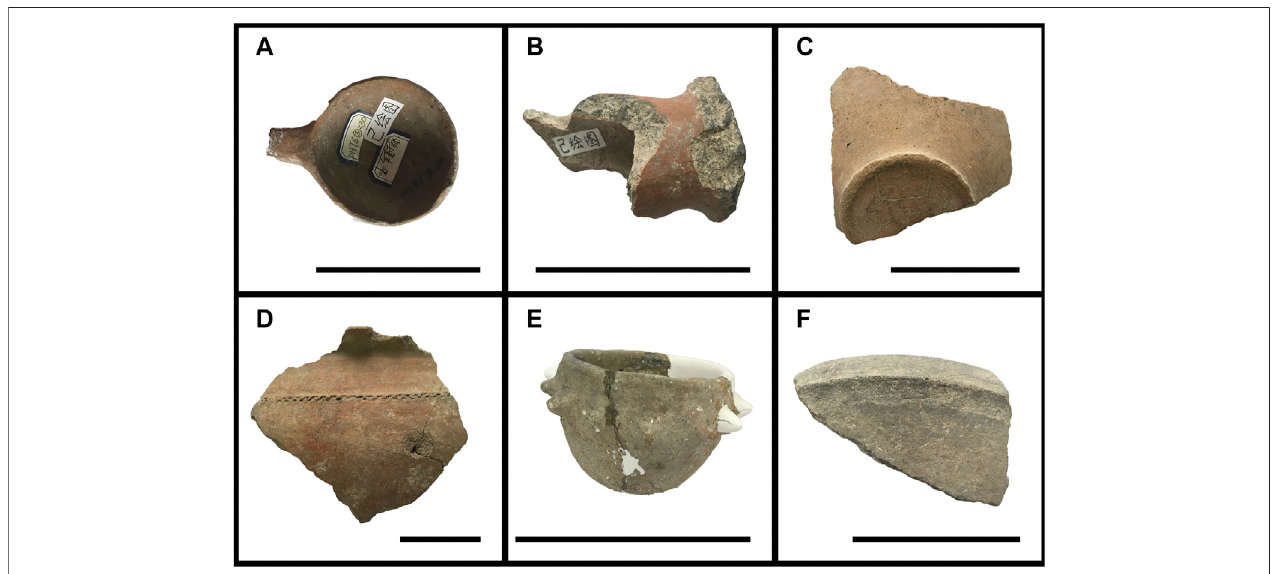
FIGURE 2 | Examples of pottery sherds subjected to starch grain analysis in this study — (A) DHT6 ③ :3A, spoon; (B) DHT3 ④ :274, a fragment from a bowl ( dou type); (C) DHT6 ④ :99, a bowl fragment; (D) DHT3 ③ :53, jar; (E) DHT3 ③ : 209, fu ; and (F) DHT3 ③ :183, a fu fragment (scale bar: 10 cm).